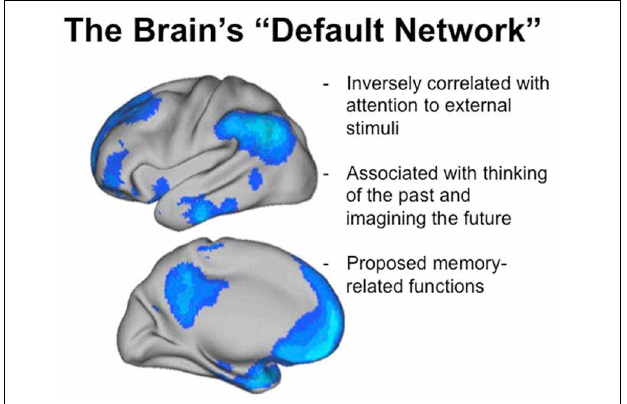
FIGURE 2 | The “Default Network” of brain function. Functional imaging studies have identified a consistent network of brain regions that are preferentially active during periods of waking rest, when participants are not engaged in processing external stimuli. Several of these same regions remain relatively active during sleep, including medial frontal and medial temporal networks involved in memory processing. (Adapted with permission from Buckner et al.,